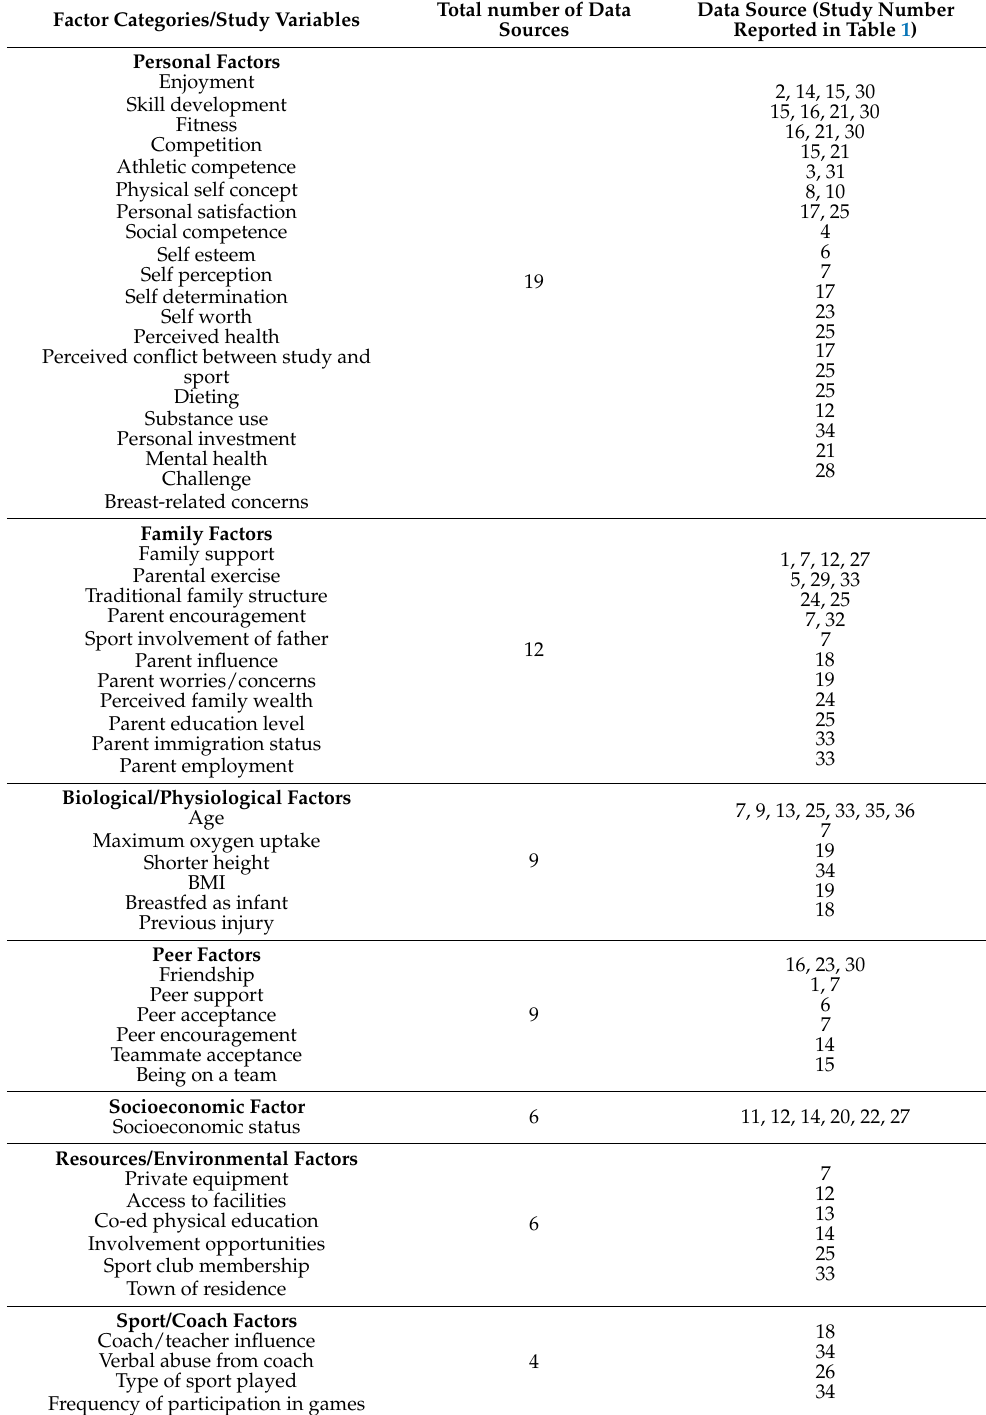
Table 2. Factors associated with sport participation among adolescent girls by data